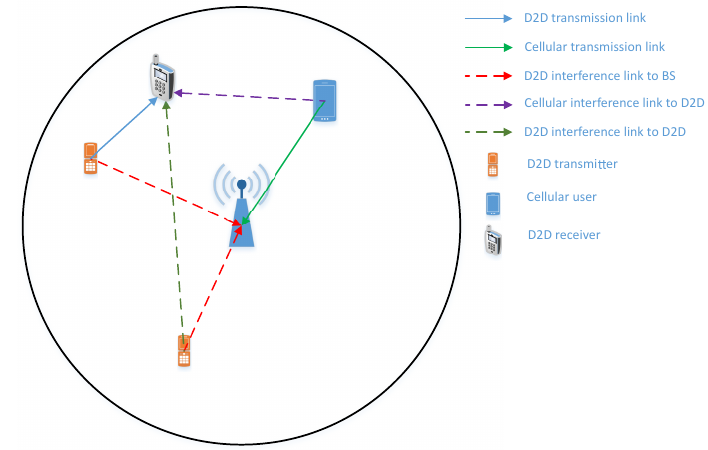
Figure 1. System model of D2D communication underlaying cellular